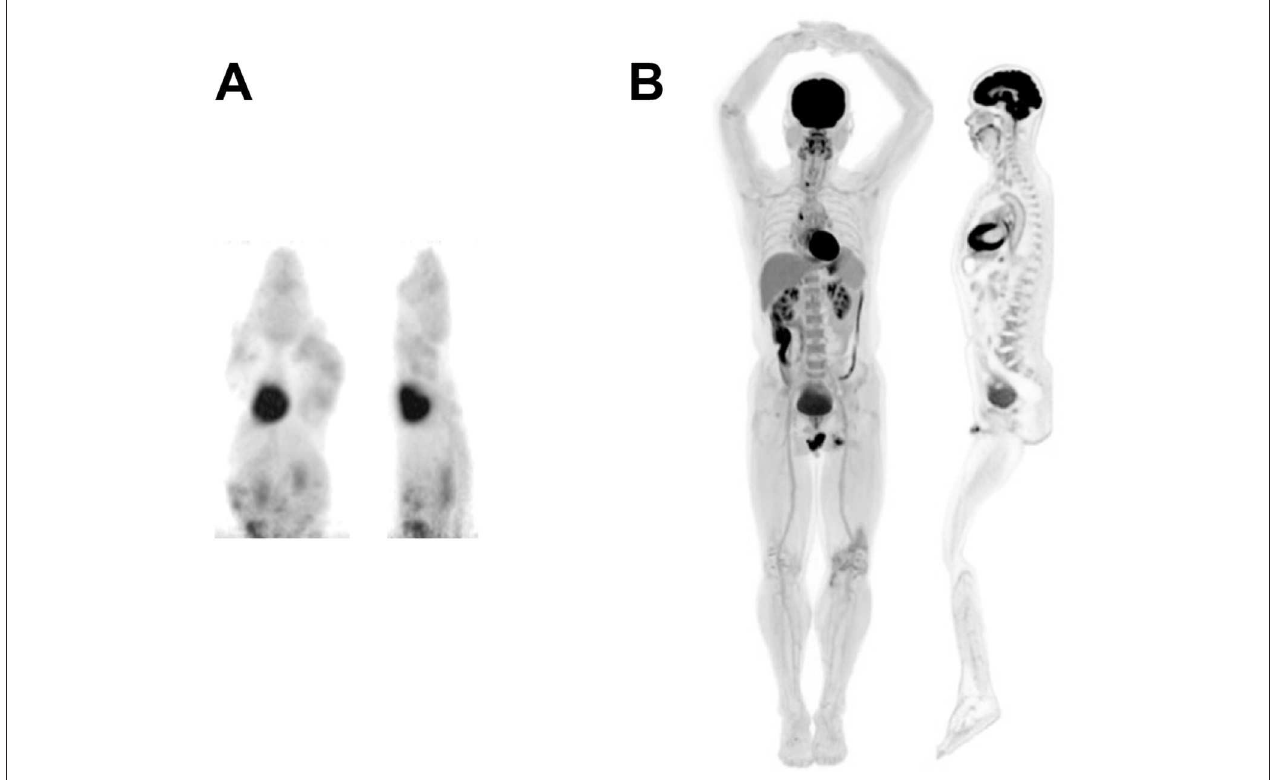
FIGURE 1 | Selected views from a (A) mouse and (B) human total-body scan showing total-body MIP and total-body sagittal view. Mouse image was acquired using the micro PET Focus 220 scanner whereas the human image was acquired using the EXPLORER total body PET scanner. This research was originally published in JNM [8].